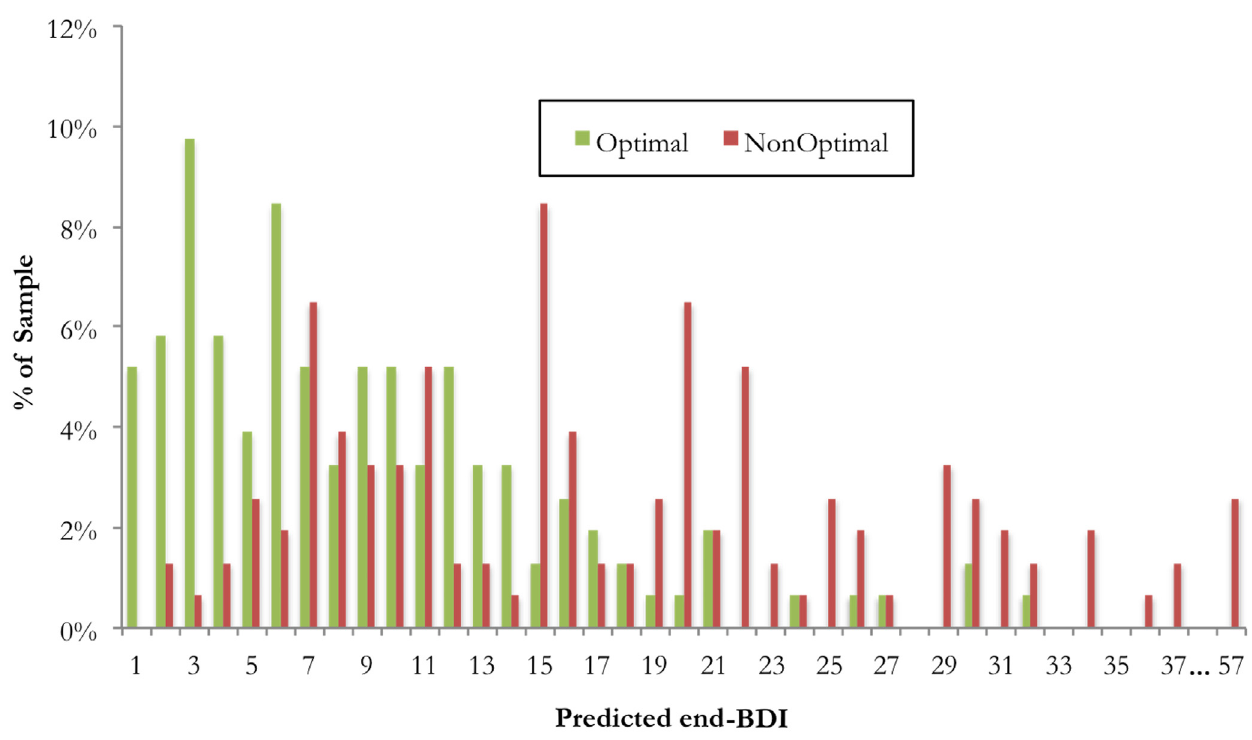
Fig 1. Frequency histogram showing predicted end-BDI scores for each patient in their Optimal and their Non-Optimal treatment, as indicated by the treatment selection algorithm.